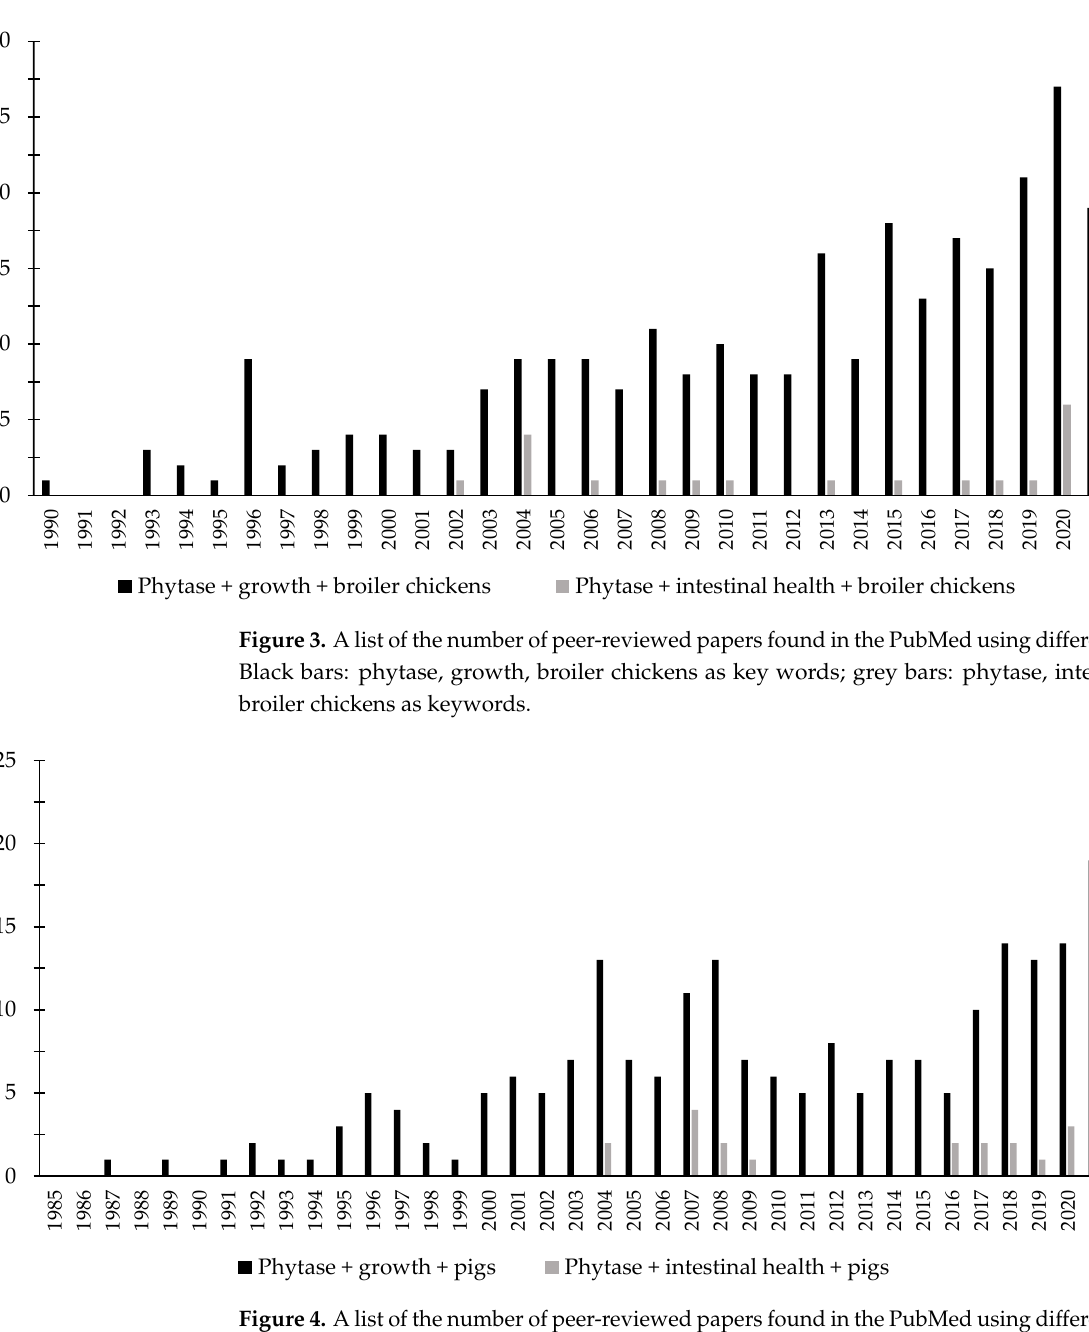
Figure 4. A list of the number of peer-reviewed papers found in the PubMed using different keywords. Black bars: phytase, growth, pigs as key words; grey bars: phytase, intestinal health, pigs as